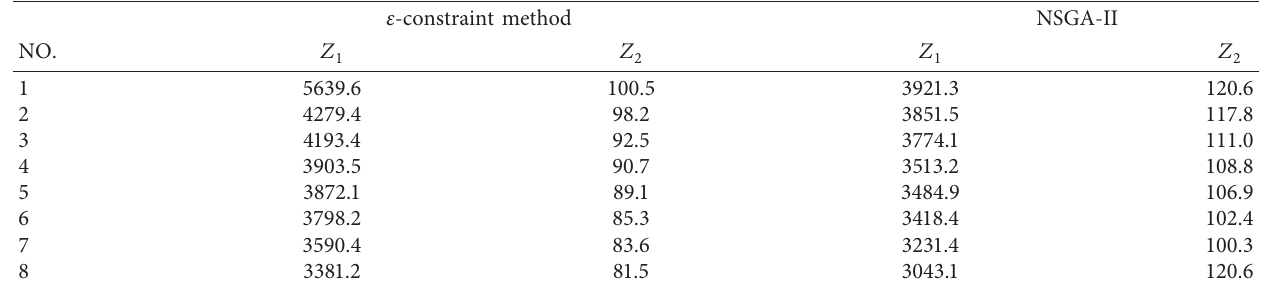
and Z for 8 groups of examples. 1 2